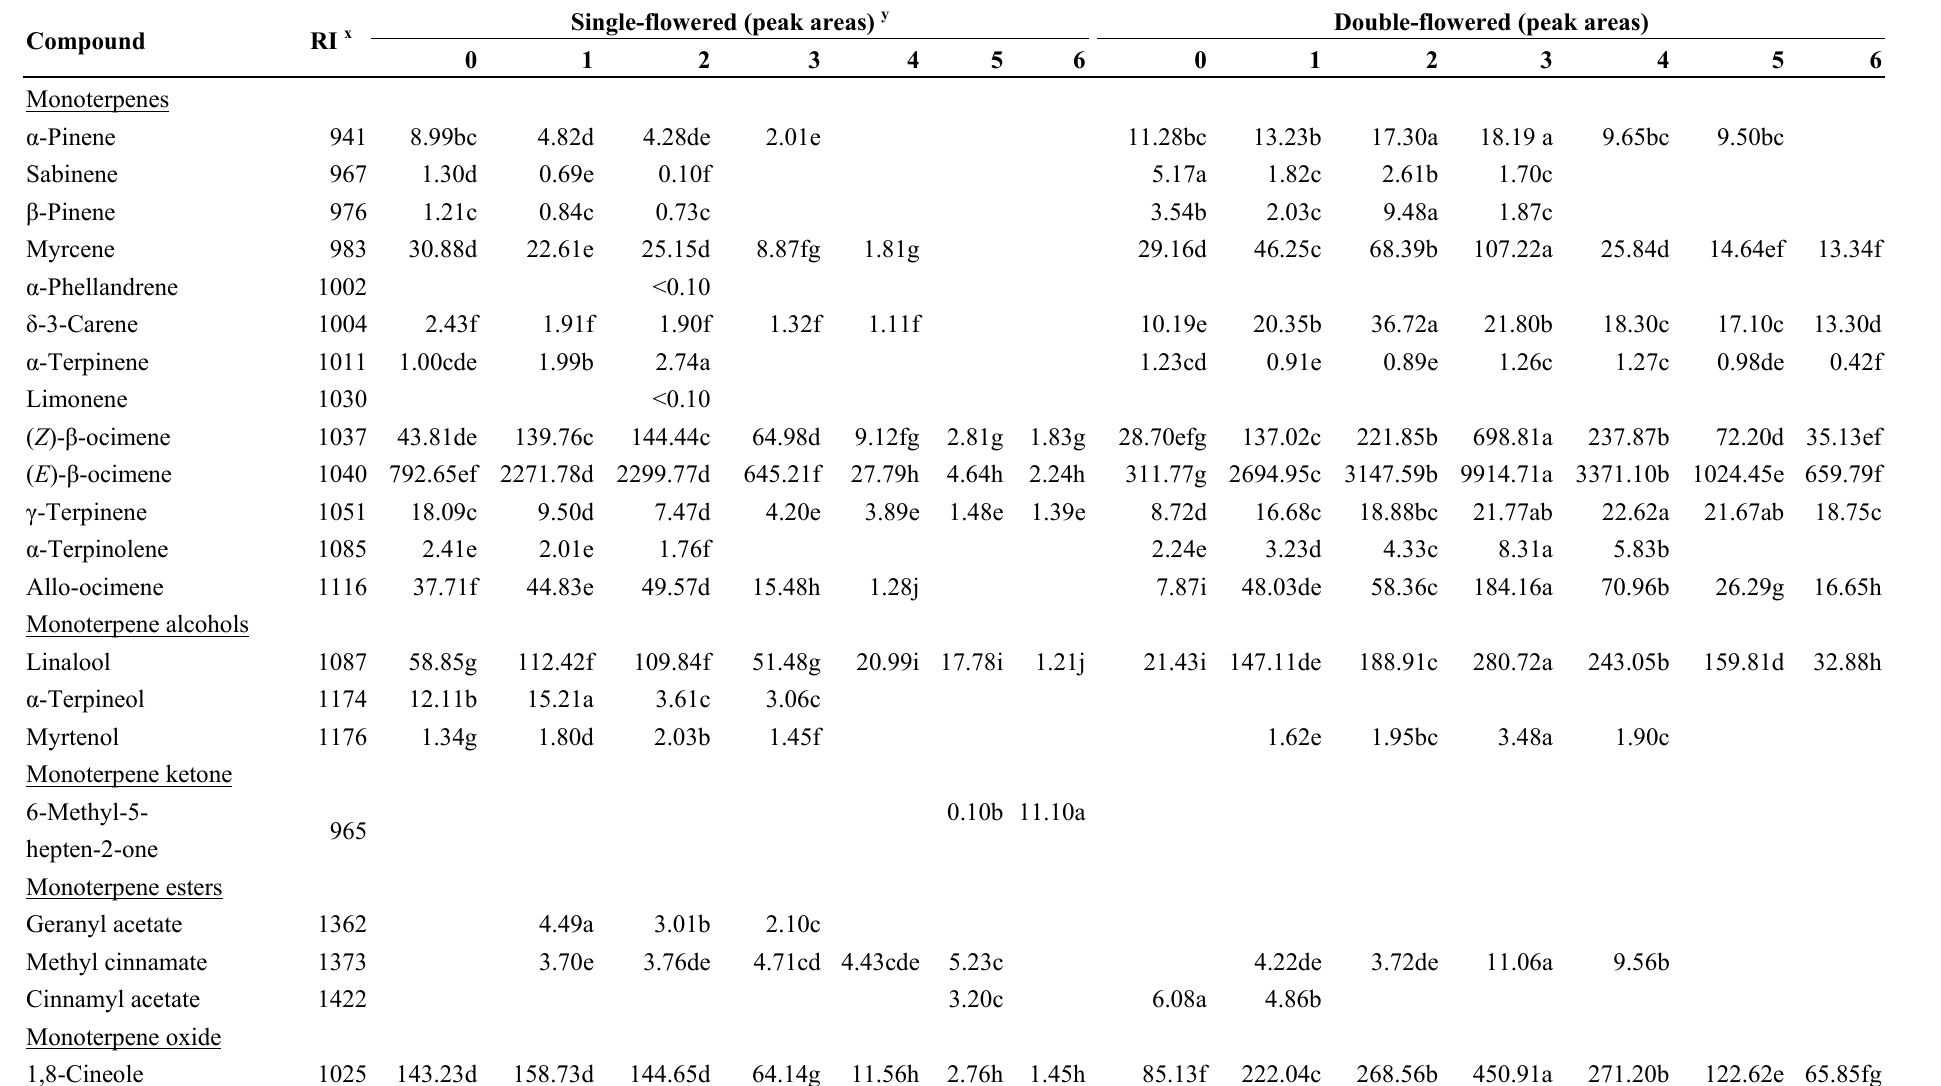
Table 3. Volatile compounds on vase life of Narcissus tazetta var. chinensis